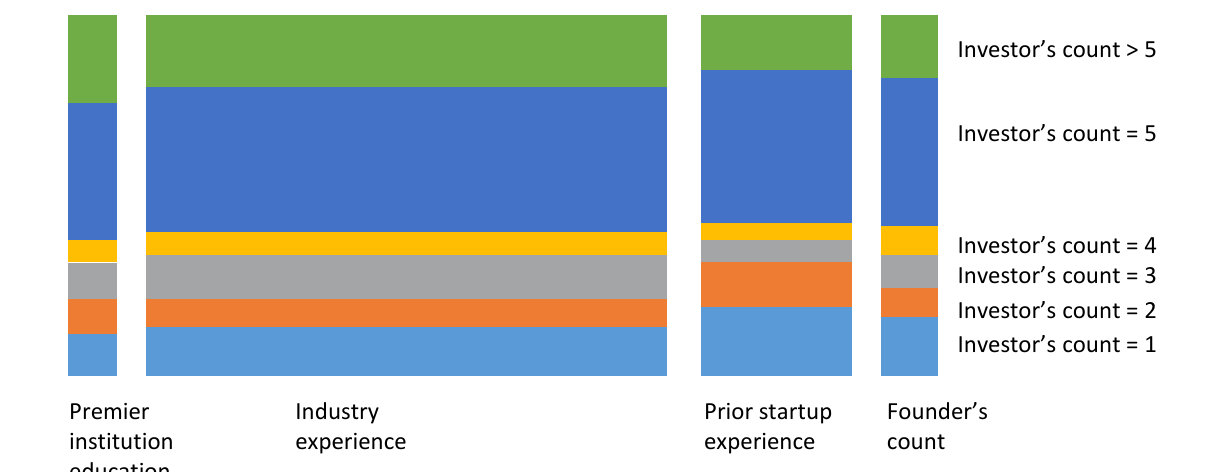
Figure 4. Mosaic plot showing relationships between number of investors and human capital variables Table 5. Estimates for number of funding rounds and number of investors attracted using Poisson